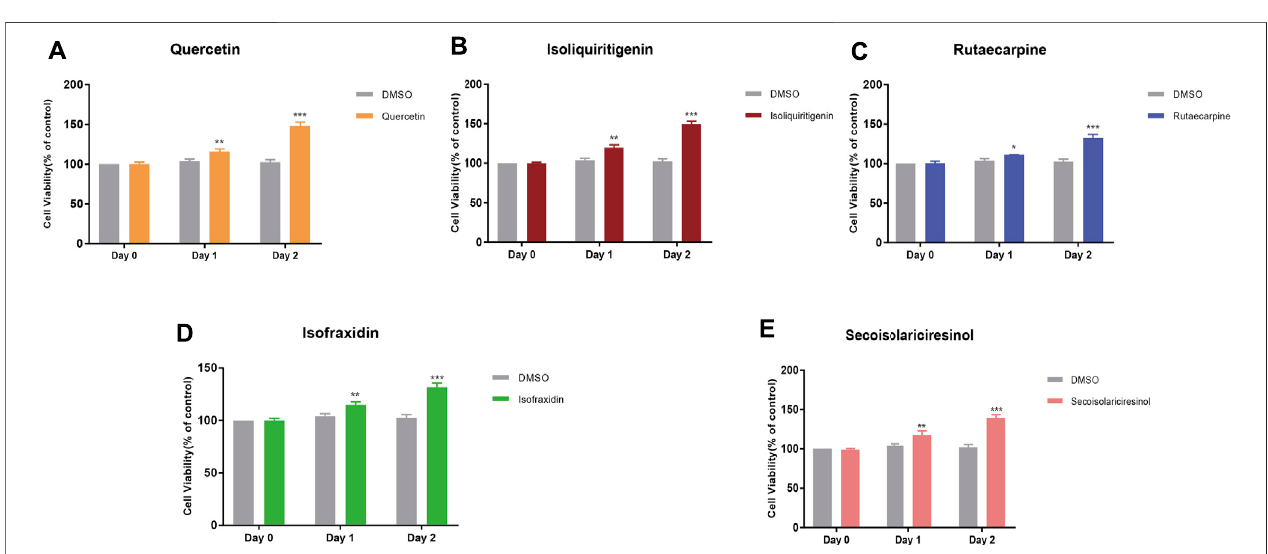
FIGURE 11 | Effects of quercetin (A) , isoliquiritigenin (B) , rutaecarpine (C) , isofraxidin (D) , and secoisolariciresinol (E) on cell viabilities on MC3T3-E1 cells. * p < 0.05, ** p < 0.01, *** p < 0.001 compared with DMSO group.